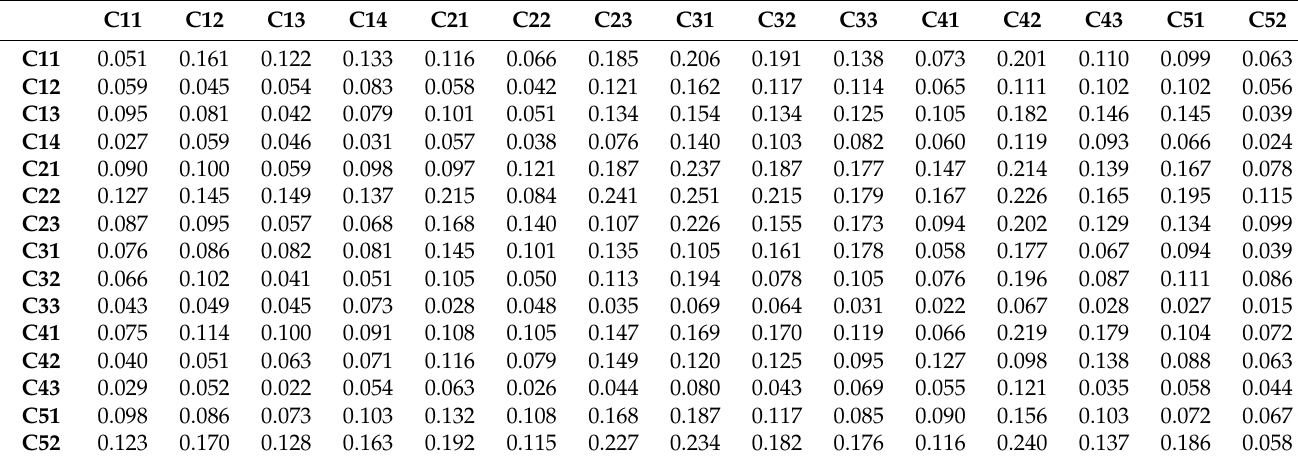
Table A6. Total relation matrix (Tc).